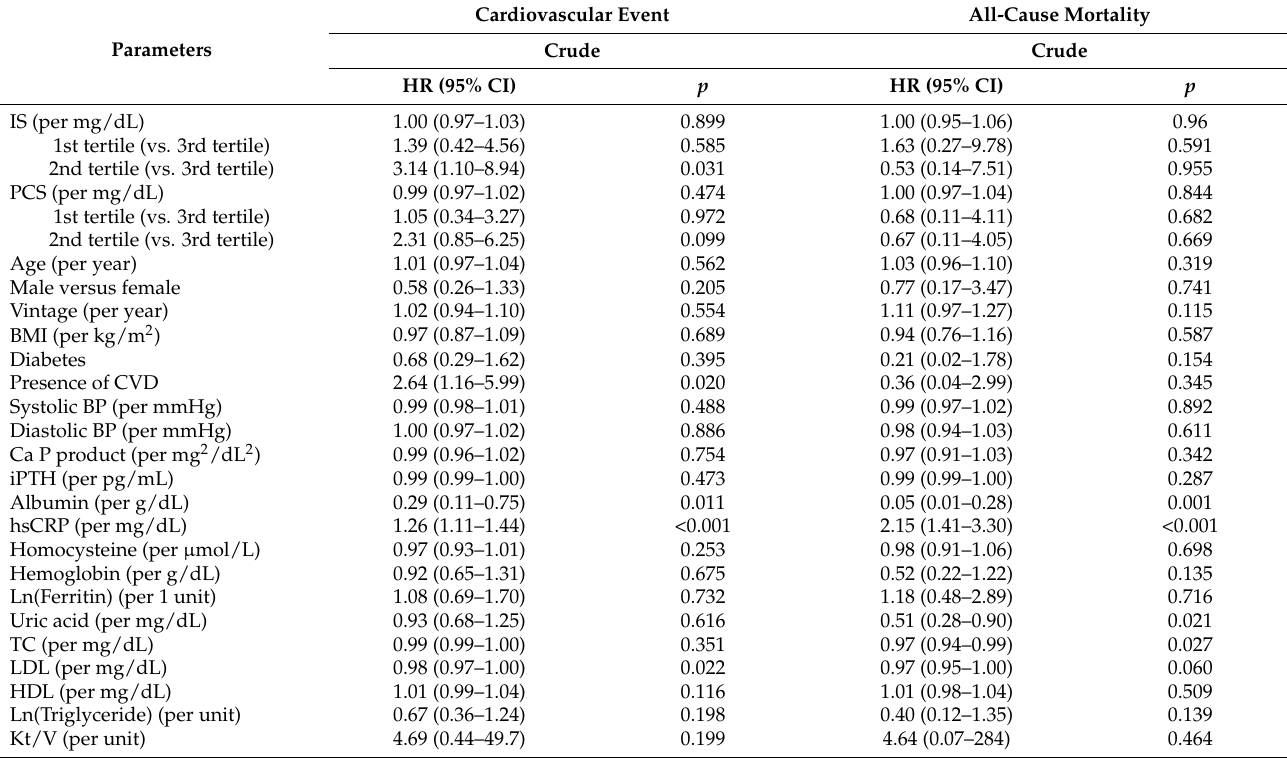
Table 2. Cox proportional regression model for evaluating the relationships among independent variables and clinical outcomes in patients with chronic